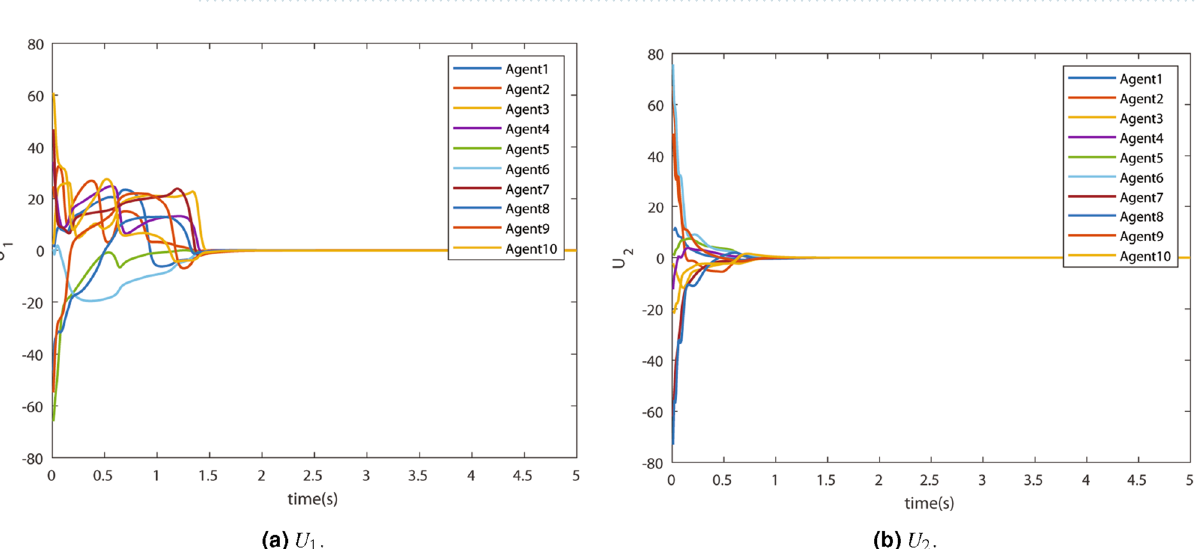
Figure 6. Neuro-adaptive